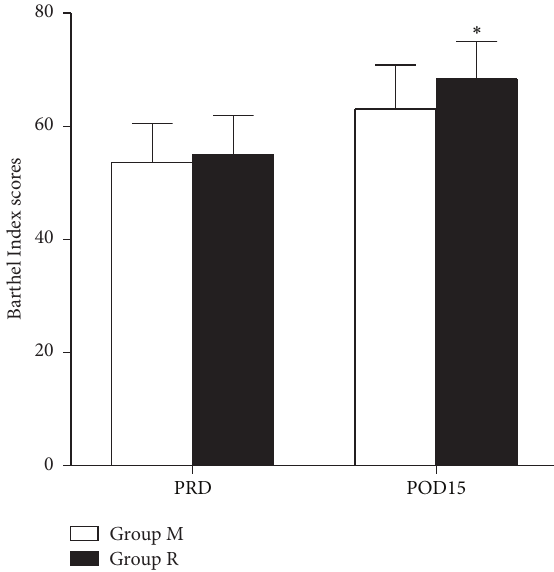
Figure 2: Barthel Index scores on pre- and postoperative days. Data are expressed as mean ± SD. ∗ 𝑃 < 0.05 compared to the group treated with morphine alone. PRD, preoperative day. POD, postoperative